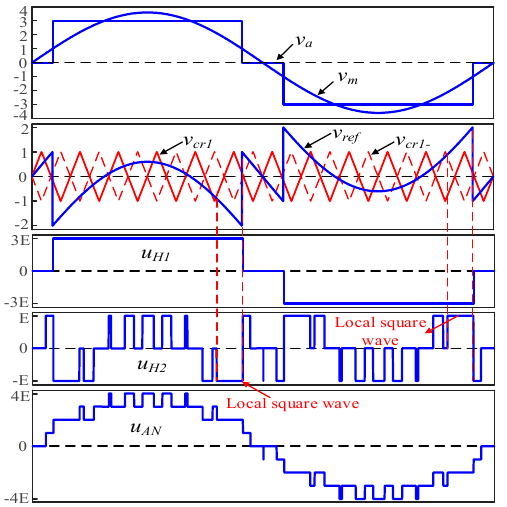
Figure 3. The principle diagram of hybrid frequency strategy.